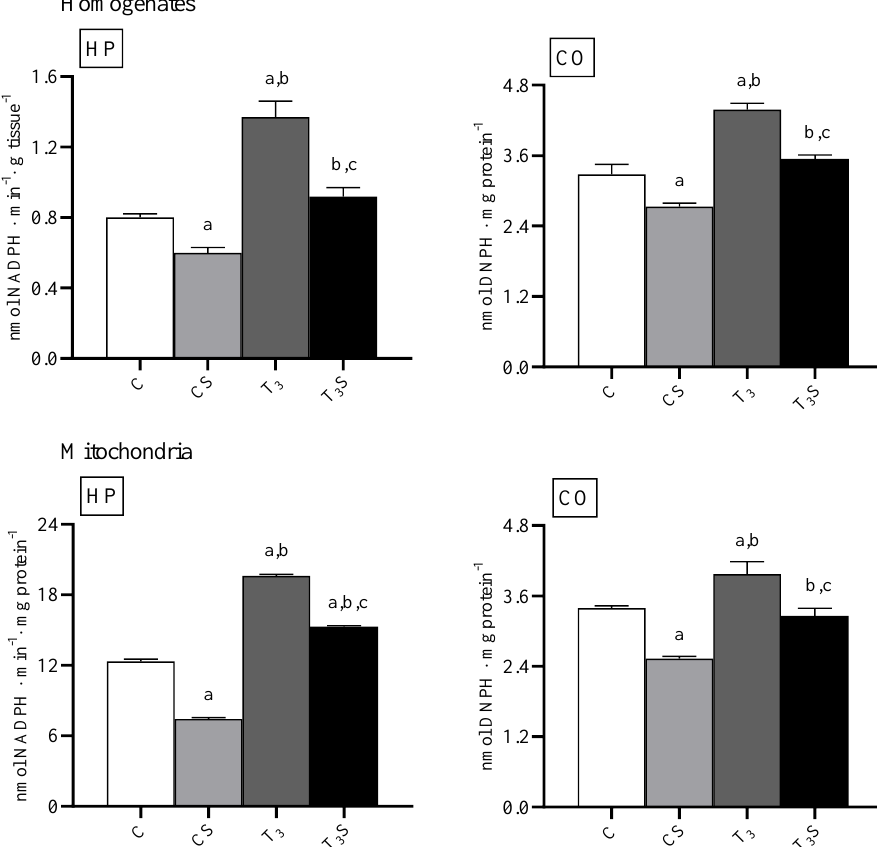
Figure 1. Levels of oxidative stress markers, lipid peroxides (HP), and protein carbonyl (CO) in rat liver homogenates and mitochondria from: C, control rats; CS, control rats fed with Chlorella sorokiniana ; T 3 , rats made hyperthyroid by ip. T 3 administration; and T 3 S, hyperthyroid rats fed with Chlorella sorokiniana . The values are the means ± SEM of the data obtained from eight different livers. a significant vs. C, b significant vs. CS, and c significant vs. T 3 . The level of significance was chosen as p < 0.05.